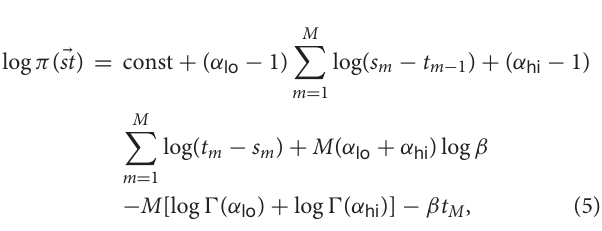
frequency shaded slate blue, with transition times as dark blue lines whose width indicates their uncertainty. Actual observed cumulative PDC event counts are shown as red